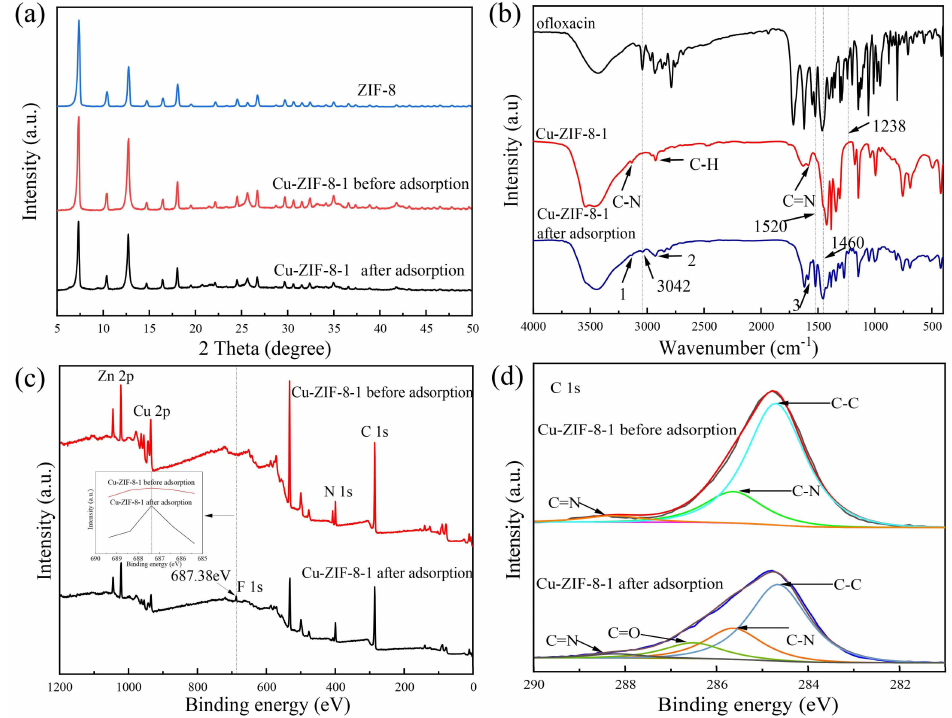
Figure 8. Comparison of PXRD ( a ), FT-IR spectrum ( b ), and XPS ( c , d ) of Cu-ZIF-8-1 before and after adsorption ( c 0 = 200 mg · L − 1